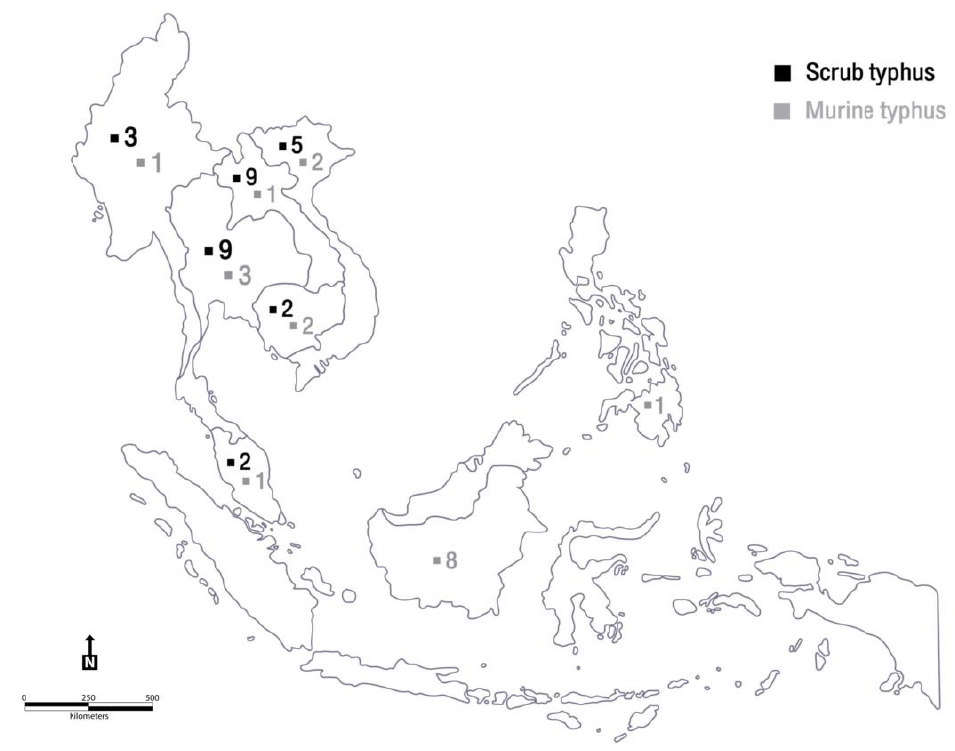
Figure 2. Demonstration of reported scrub typhus and murine typhus cases in Southeast Asia. Figure by Mrs. Siwaporn Panphoowong (Adobe